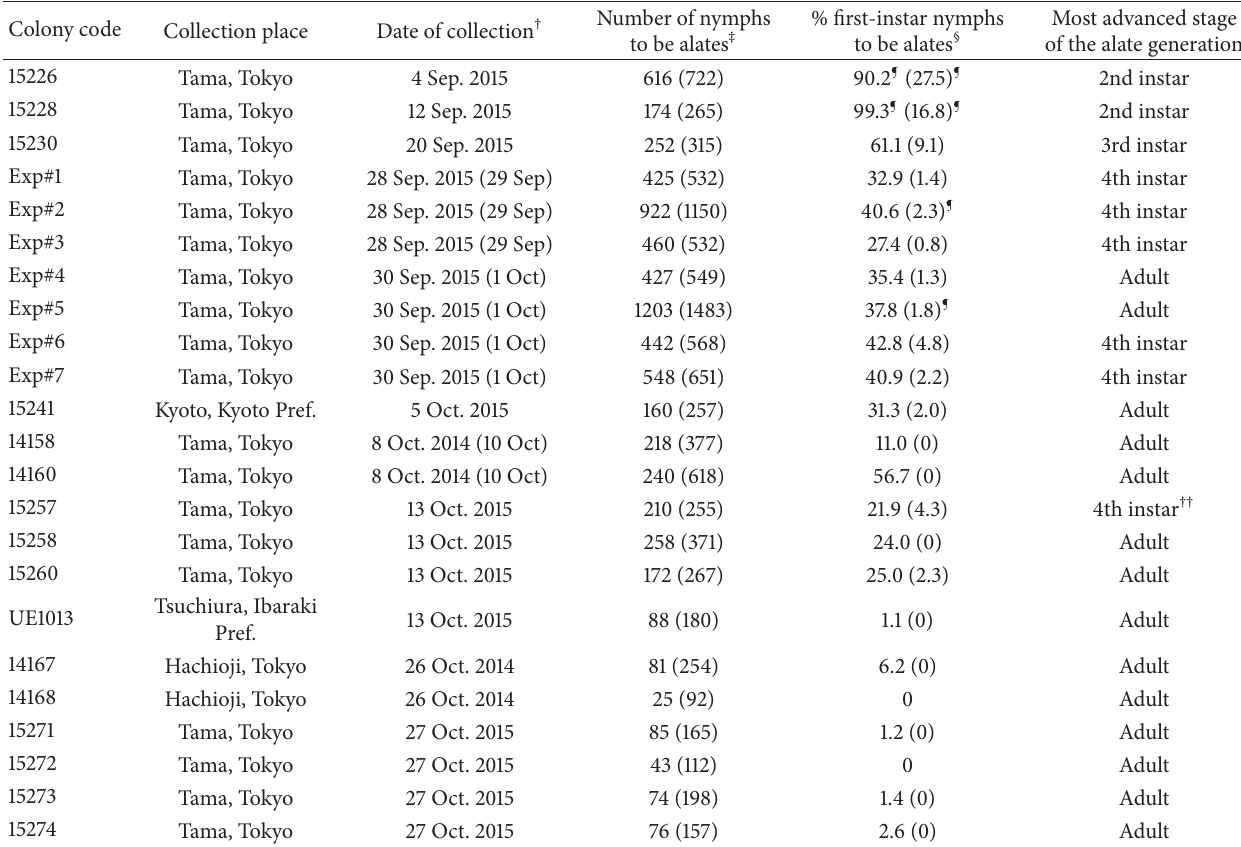
Table 1: Collection data, the number of nymphs to be alates, the percentage of first-instar nymphs and their molting rate, and the most advanced stage of the alate generation for 23 woolly